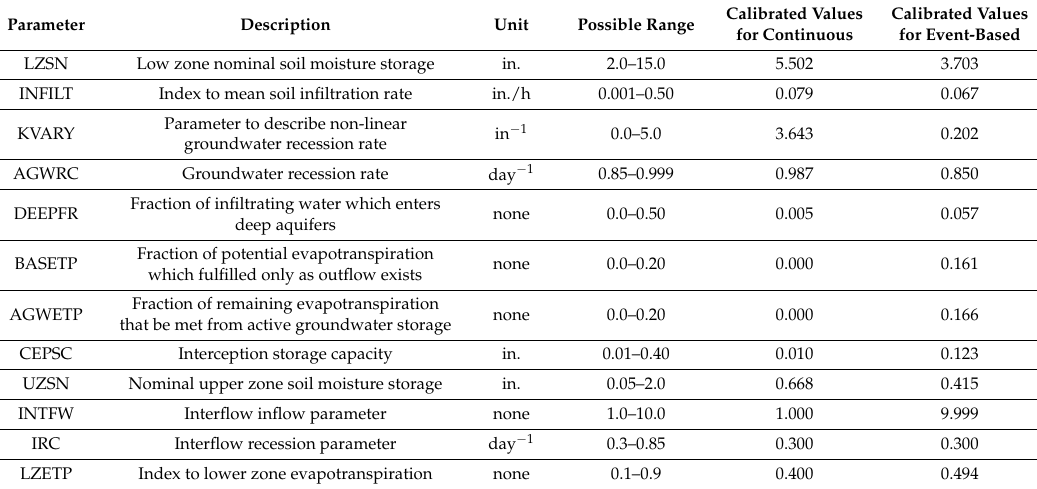
Figure 3. Water storages and movement represented in the PERLND module. ET: evapotranspiration, AGWS: active ground water storage, LZS: lower zone storage, UPS: upper zone storage, IFWS: interflow storage, SURS: surface detention storage, CEPS: Interception storage. Table 3. Descriptions of the hydrologic parameters calibrated in the HSPF model.